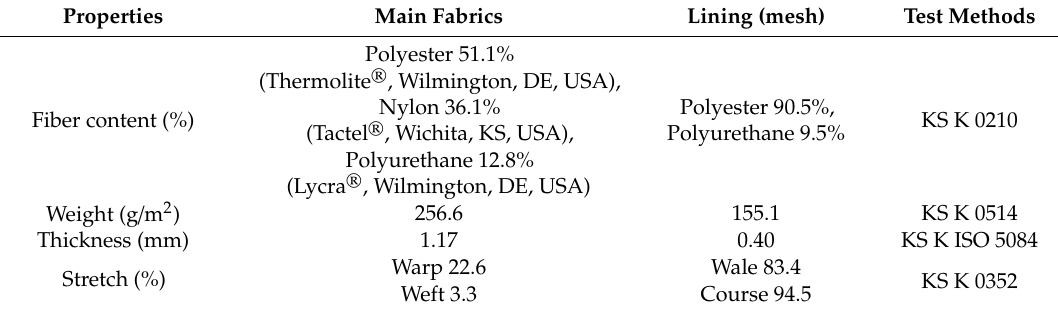
Table 1. Properties of the fabrics used in this